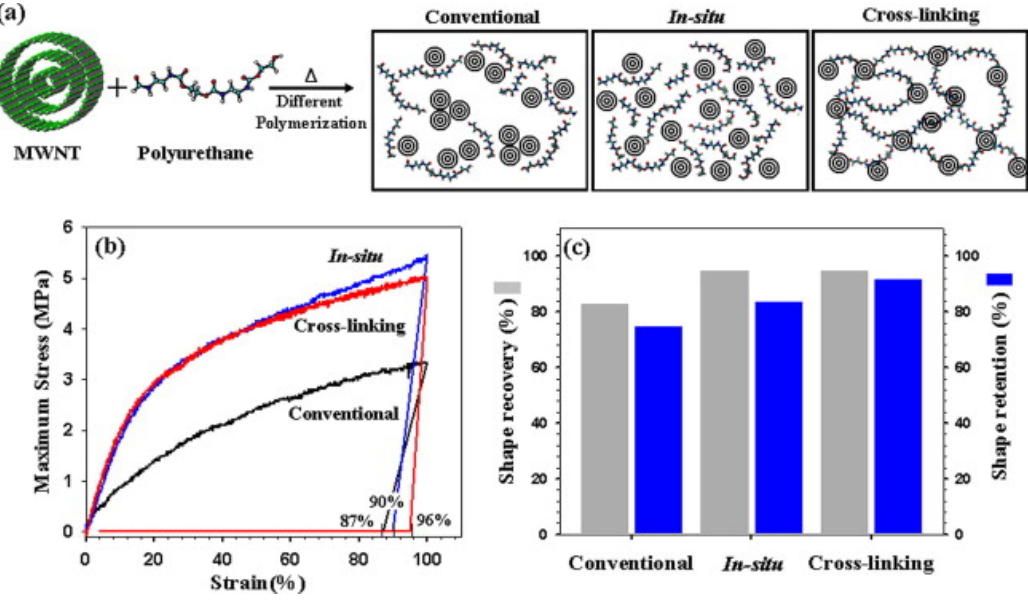
Figure 7. ( a ) A schematic representation of the controlled dispersed structures of the tubes within the polymer matrix; ( b ) thermomechanical properties curves (200% elongation at 50 °C); and ( c ) shape recovery and shape retention (quenching/unloading and subsequently applying an electric voltage of 40 V) for the polyurethane composites prepared by conventional blending, in situ , and cross-linking polymerization. Reproduced from Reference [104] with